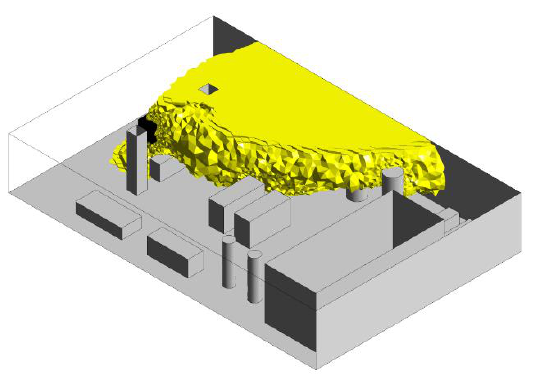
Figure 14. IDLH volume for U ref = 10 m/s. The emitting cube is shown in black.